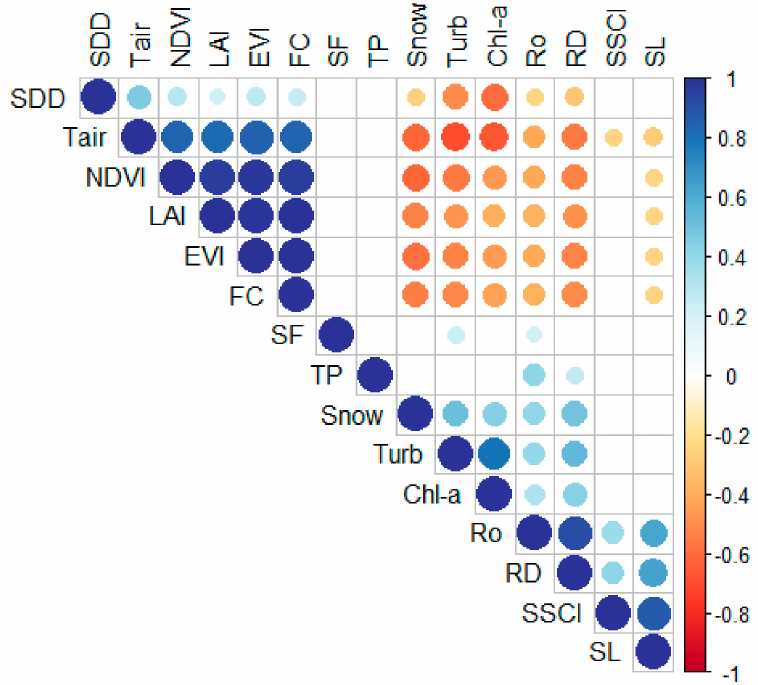
Figure 5. Cross-correlation plot of the considered variables inside the Banja watershed. The dimension of the points is proportional to the correlation degree. Only significative correlations are